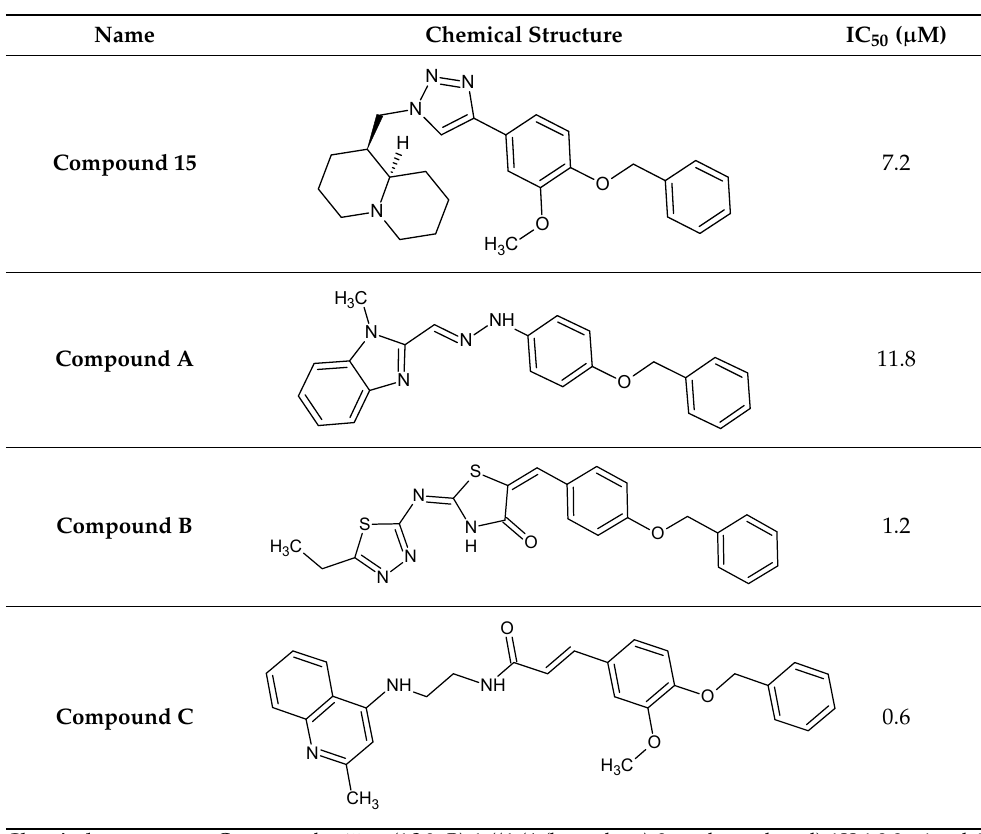
Figure 1. Representative double-reciprocal Lineweaver–Burk plot illustrating the mixed-type mech- anism of AChE inhibition by compound 15 . Table 3. Chemical structures and AChE inhibitory activities of lupinine derivative 15 and previously reported AChE inhibitors with a 4-benzyloxyphenyl moiety [36–38].